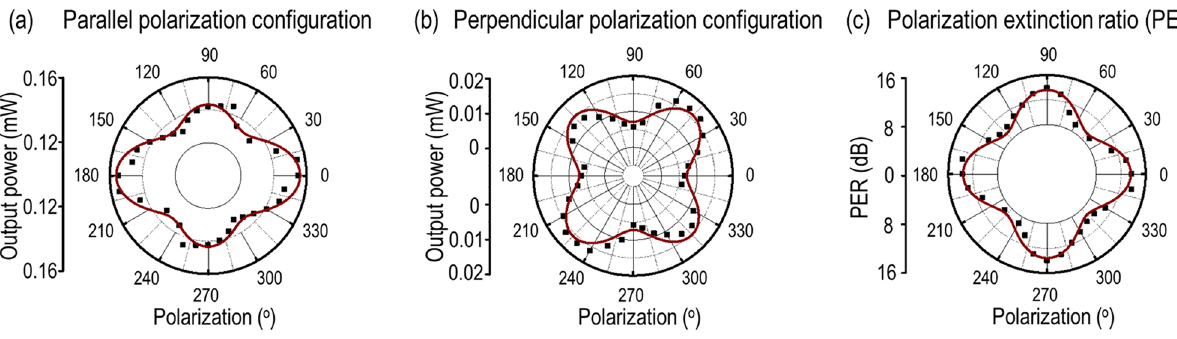
Figure 6. Quantification of polarization extinction ratio in gerstleyite flake. ( a,b ) Angle-resolved plots of transmission power variations in parallel and perpendicular polarization configurations through the 472 nm-thick gerstleyite flake. ( c ) Angular polar plot of PER values. The measured values are shown with black squares, while the fitted curves are shown with brown solid polarization angle of 0°, 45°, 90°, and 135°. It can be observed that the brightness of the probed flake is highest when the crystal’s optical axis of a -axis and c *-axis which are labeled as x -axis and y -axis in Fig. 5a is aligned at the 45° and 135° incident polarization direction, compared to the case when the crystal’s optical axis is orientated at the 0° and 90° incident polarization direction. Such periodic variation in flake brightness is attributed to the birefringence effect of anisotropic gerstleyite crystal. This observed birefringence effect can be ascribed in the context of the outcoupled polarization state of transmitted light 53,54 . When the incident linear polarization is aligned with the probed crystal’s optical axis ( a -axis and c* -axis), the outcoupled polarization state of transmitted light remains unperturbed. As a result, the output polarization is still perpendicular to the direction of the engaged linear analyzer in the collection path so that the transmitted image appears dark. In contrast to this, when the alignment of incident linear polariza- tion is away from the crystal’s optical axis, the transmitted light passing through the probed crystal experiences the phase retardance and then the outcoupled polarization state of transmitted light transforms into elliptically polarized. The intensity of such phase retardance induced elliptically polarized light will obtain the maximum value at the incident linear polarization angle of 45° and 135°. Therefore, the flake brightness exhibits periodic variation as a function of the incident linear polarization angle with the maxima at 45° and 135° and the minima at 0° and 90°. To further quantify and reaffirm this trend, the transmitted images are processed by normalizing the background intensity. Furthermore, the brightness contrast between flake and glass substrate is computed at different illumination light polarization. Figure 5b plots the transmitted light intensity as a function of the incident linear polarization angle under the cross-polarization illumination configuration. The measured values are shown with black squares, whereas the theoretical fitting is shown with brown solid line according to the 2 ( 2 θ) equation T = t · sin , where t denotes the transmittance along crystal’s axis. The measured flake brightness demonstrates a four-lobes pattern with the maxima at 45° and 135°, as well as the minima at 0° and 90°. In addi- tion, the experimental data shows a good agreement with the theoretical fit which future validates the observed birefringence effect.